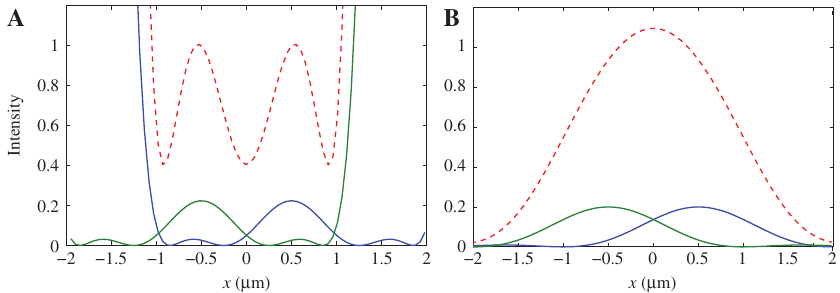
Figure 11: The comparison of the imaging of two subwavelength-separated sources via (A) an SOL lens and (B) a traditional lens. = d = 30 mm, a = 10 mm, λ = 500 nm, and the sources were separated by 2/3rds the resolution limit. The dashed line indicates the Here d o i total